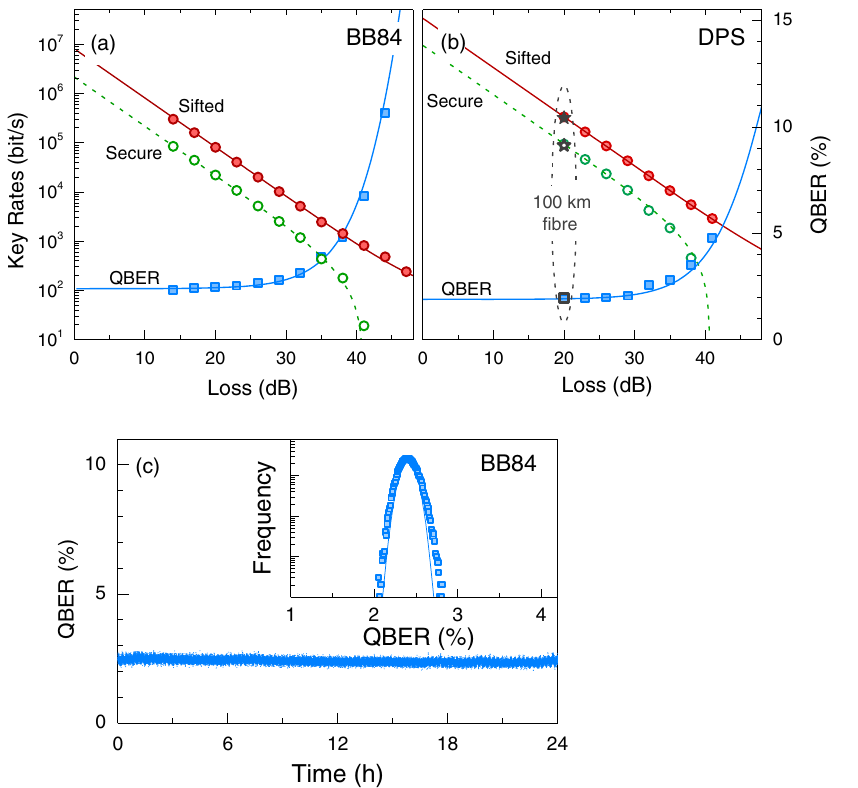
FIG. 4. QKD operating with the directly phase-modulated light source. Sifted and asymptotic secure rates and QBER versus channel loss for (a) BB84 and (b) DPS protocols. These QKD protocols use different security assumptions, and further details can be found in Appendix B. (c) QBER measured with the BB84 protocol for a duration of 24 hours. The inset shows the distribution of the measured QBER ’ s (symbols) together with a simulation (line) of the shot-noise statistical fluctuation from the finite count rate. The signal integration time is 1